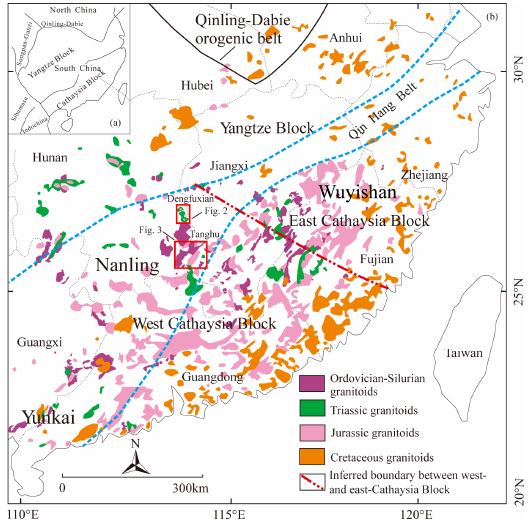
Figure 1. The sketch tectonic location of the South China Block ( a ) and the Geological sketch map of the South China Block ( b ), modified from [58]. The inferred boundary between the West and East Cathaysia Block is modified from [4]. The red box refers to the study regions, whereas the area be ‐ tween the blue dashed lines refers to the Qian ‐ Hang Belt of SE China. The grey dushed lines refer to the provincial boundaries.